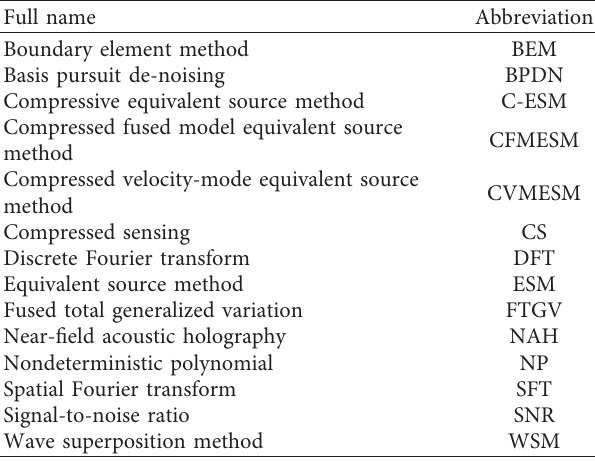
Figure 8: Acoustic pressure reconstruction error with frequency for various acoustic field reconstruction methods with 64 sampling points. Table 1: Comparison of full name and abbreviation in this